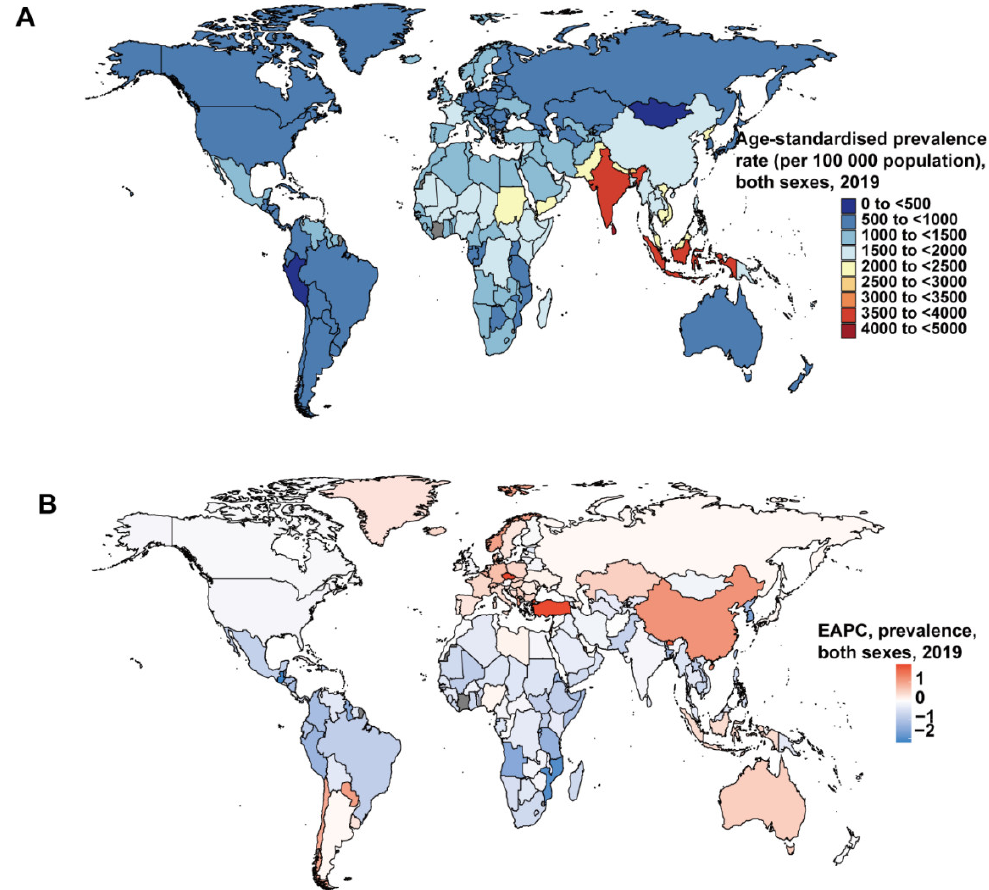
Figure 2. The global disease burden of protein–energy malnutrition for both genders in 204 countries and territories. ( A )The age-standardized prevalence rate (ASPR) of protein–energy malnutrition in 2019. ( B ) The estimated annual percentage change (EAPC) in ASPR of protein–energy malnutrition from 1990 to 2019.